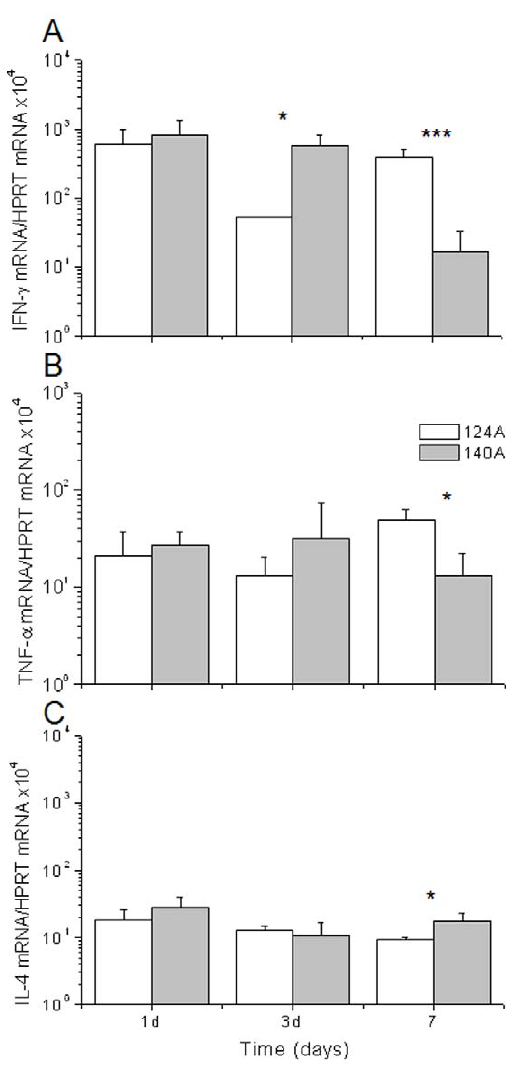
Figure 5. Real time PCR cytokine quantification. RNA was extracted from spleen homogenates in HBSS of mice infected with 10 6 yeast cells of 124A ( % ) or 140A ( & ) by using the Trizol method and mRNA levels of IFN- c (A), TNF- a (B) and IL-4 (C) quantified and expressed as copies per HPRT gene. Statistical significance was calculated by using Student’s t test and significant differences are labeled with a single asterisk ( P , 0.05) or triple asterisks ( P , 0,0001).